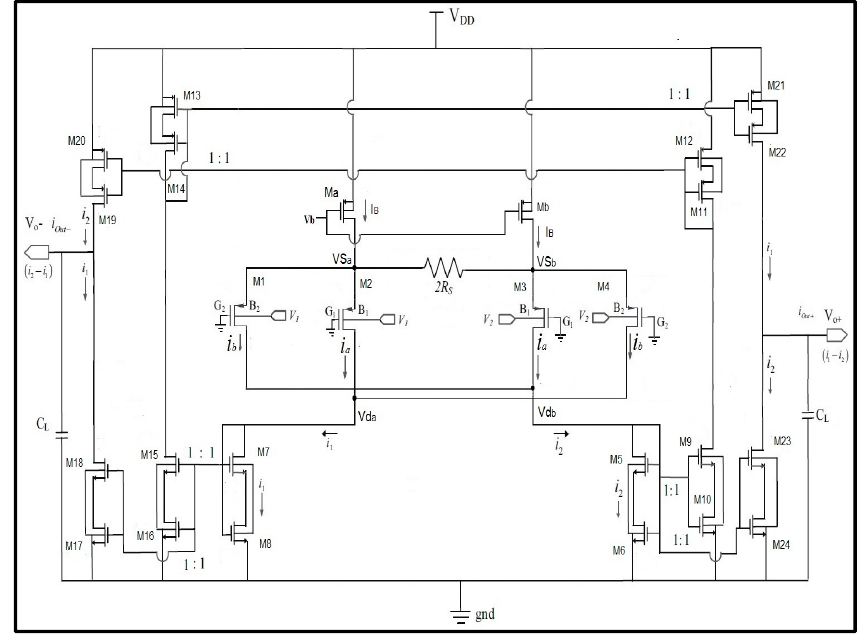
Figure 4. Schematic of the bulk driven fully differential self-cascode OTA.